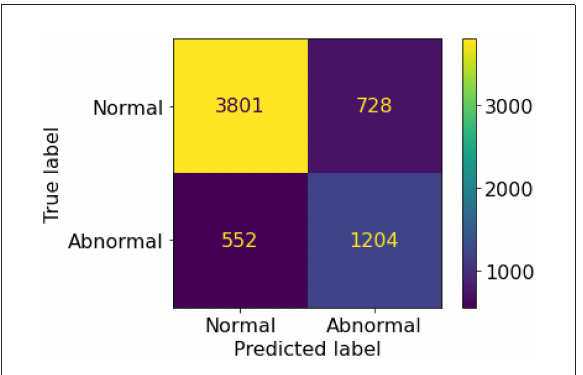
FIGURE5 Confusion matrix of the VinDr-CXR abnormality classifier.